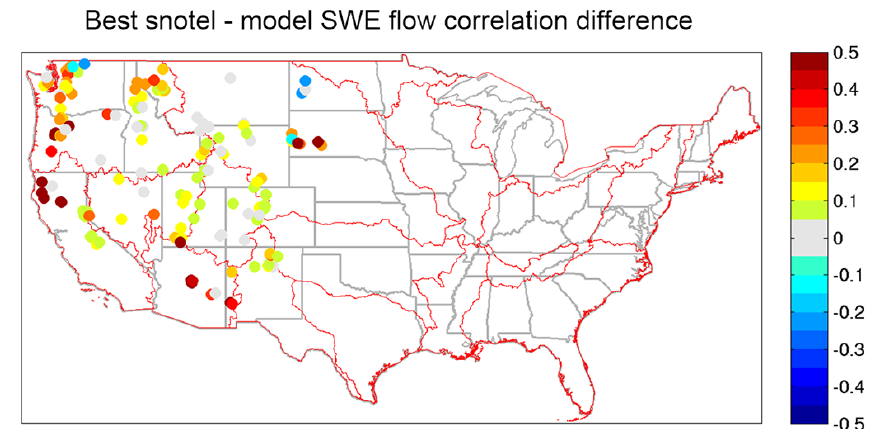
Figure 7. Difference of the rank correlation of SWE and runoff from the best SNOTEL site (of nearest 10) and calibrated model without